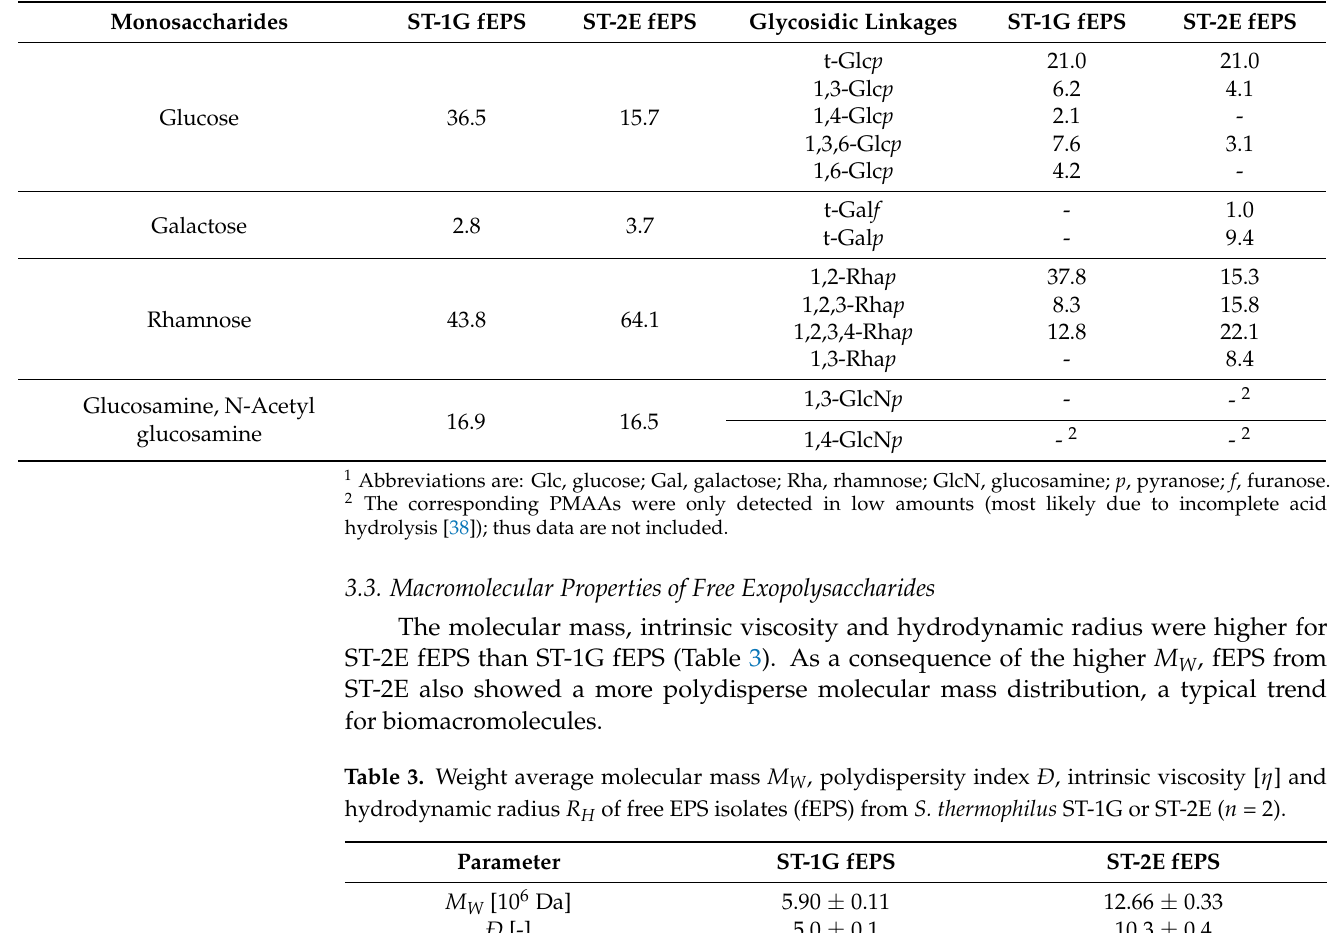
Table 2. Monosaccharides (mol%, determined by HPAEC-PAD after TFA hydrolysis) and glycosidic linkages (mol%, determined by methylation analysis) in fEPS from ST-1G and ST-2E 1 .